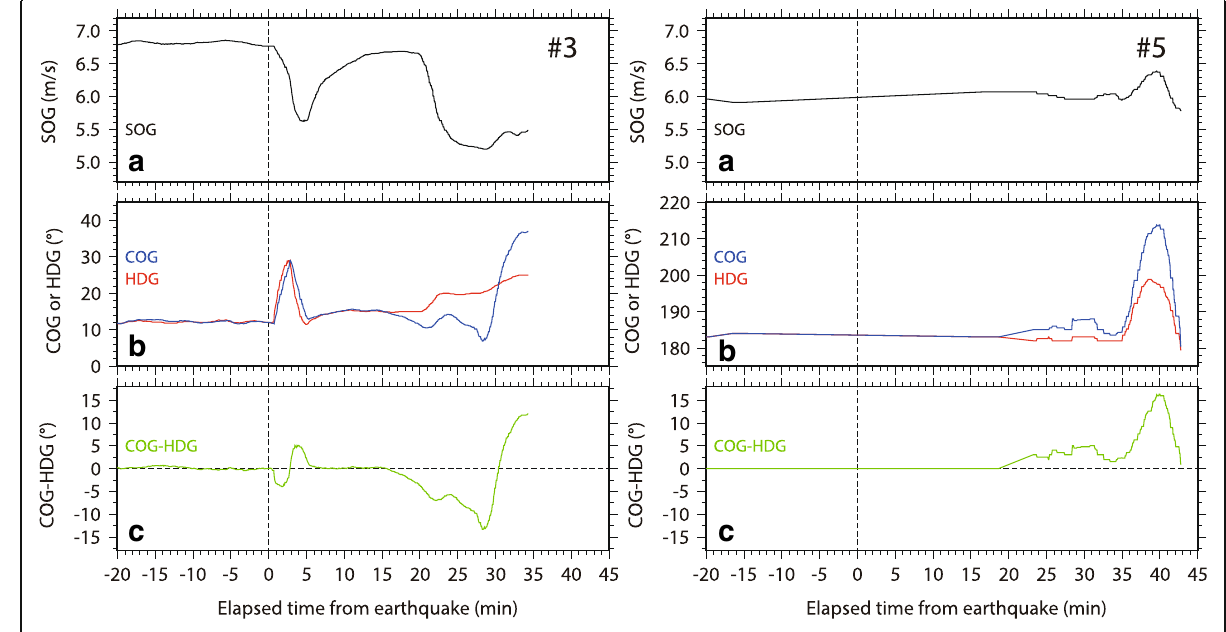
Fig. 4 a SOG, b COG/HDG, and c COG minus HDG of two selected ships (#3 and #5 in Fig.